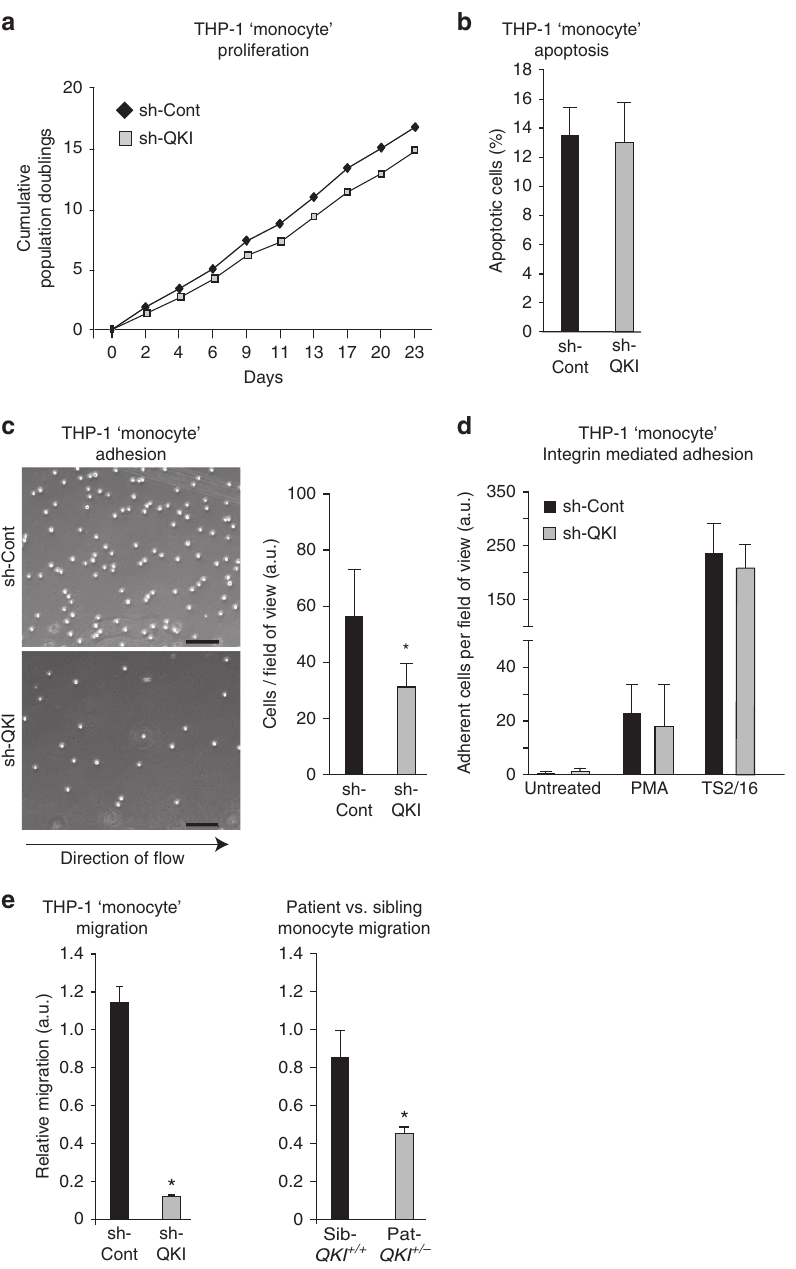
Figure 7 | QKI expression levels have an impact on monocyte adhesion as well as migration and differentiation. ( a ) Cumulative population doublings ( y axis: CPDs) were counted to assess the effect of QKI reduction on cellular proliferation over time ( x axis: days). Population growth curves were compared using linear regression analysis.( b ) Quantification of cellular apoptosis, where annexin V þ and propidium iodide þ cells were categorized as apoptotic, as determined by FACS analysis. ( c ) Quantification of sh-Cont and sh-QKI THP-1 ‘monocyte’ adhesion to collagen matrix pretreated with platelet-rich plasma under flow, mimicking in-vivo endothelial denudation. Direction of flow is indicated below the photomicrographs ( n ¼ 3). Data expressed as mean ± s.e.m.; Student’s t -test; * P o 0.05. Scale bar, 100 m m. (Also see Supplementary Movies 1 and 2). ( d ) Assessment of integrin-mediated adhesion. Quantification of adhesion to collagen for untreated, PMA- or TS2/16-treated sh-Cont and sh-QKI THP-1 ‘monocytes’ are plotted. TS2/16 is an antibody that turns